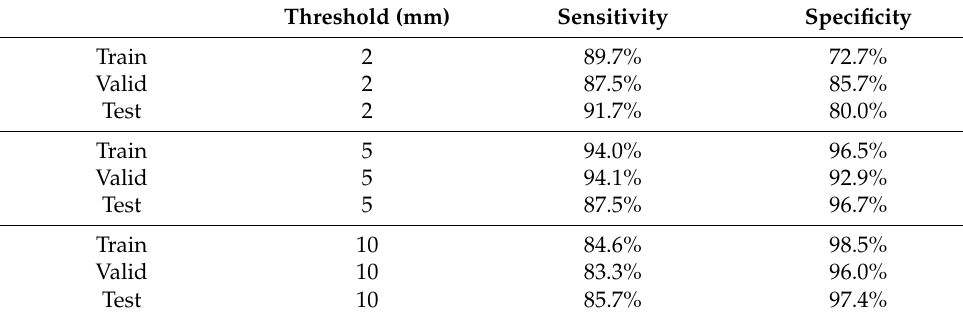
Table 4. Sensitivity and specificity for detection of midline